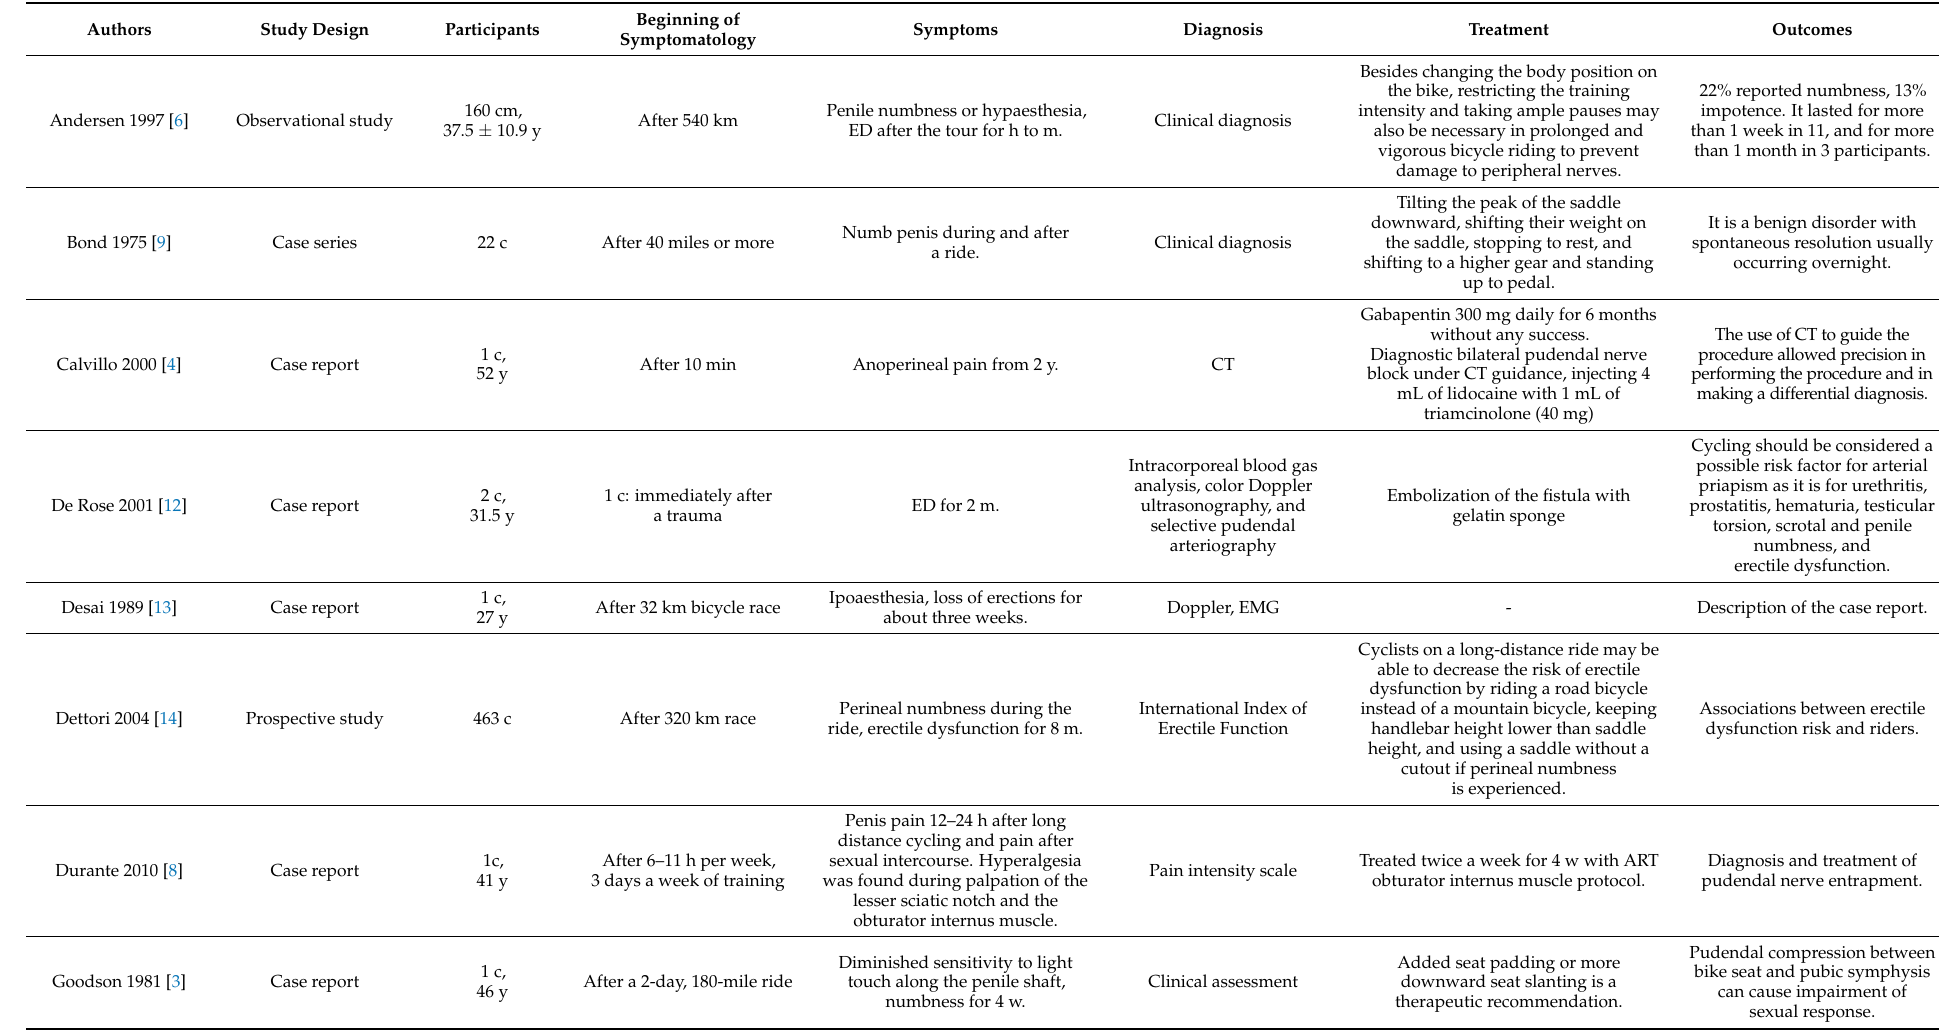
Table 1. Characteristics and outcomes of studies included in the systematic